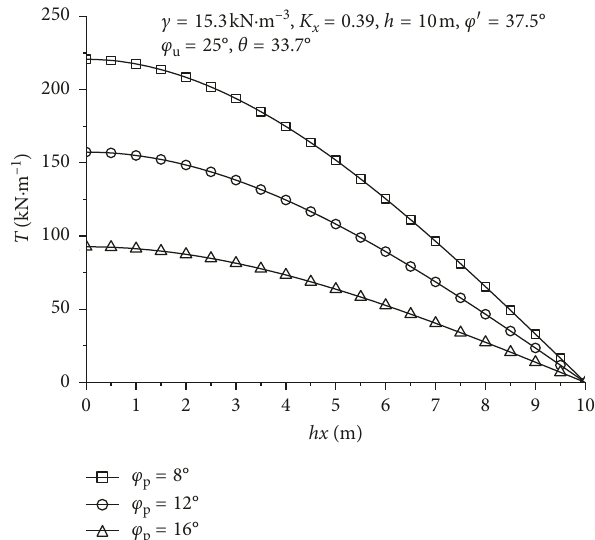
Figure 6: Change of the tensile force in the membrane at different depths.